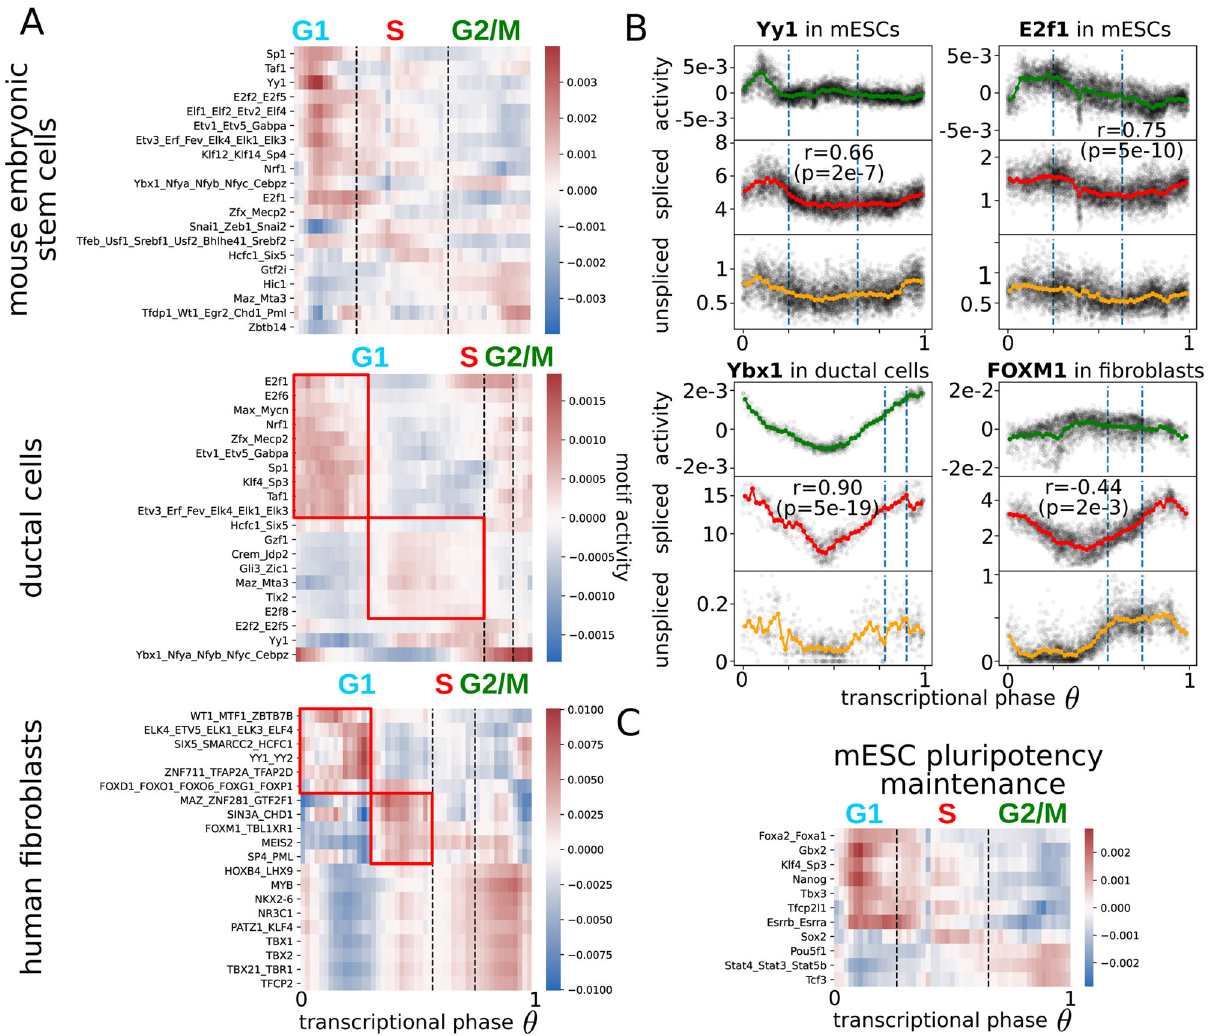
Fig. 4 Transcription factor dynamics driving expression during the cell cycle. A Motif activities for families of transcription factors across the cell cycle in mESCs, ductal cells, and human fi broblasts. The red boxes identify two waves of transcription in the G1 phases for more differentiated cell lines. B The comparison of motif activities with the respective mRNA levels around the cell cycle for Yy1 and E2f1 in mESCs, Ybx1 for ductal cells, and FOXM1 for human fi broblasts. These comparisons allow clarifying whether the regulation is happening more at the transcriptional level or the protein level. The Pearson ’ s correlation coef fi cients between spliced reads and motif activities are reported ( r values) as well as the exact tests of no-correlation ( p values). C Dunn et al. 58 identi fi ed two sets of TFs at the core of the pluripotency maintenance network in mESCs, the fi rst responsible for the integration of the signals (input) and the latter for taking a fate decision (computation). The heatmap shows their activities around the cell cycle of mESCs for the pluripotency factors for which the binding motifs are known. The ‘ input ’ motifs are active in late G2/M while the ‘ computation ’ factors in the early